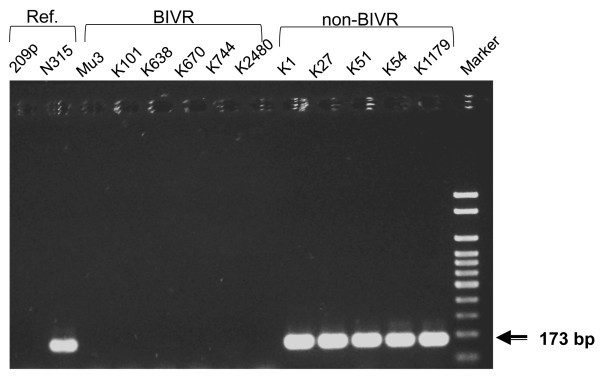
Agarose gel electrophoretograms of the PCR product. Primer K was used for the PCR of blaZ and the conditions for the thermal cycler setting are given in the text. A fixed agarose concentration (2%) was used. The gel was stained with GelRed and visualised under UV light. Marker, LowRange 100 bp DNA markers; FDA209P, negative control; N315, positive control; the MRSA class and strain number are shown in the figure.